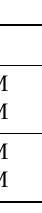
Table 1. The IC 50 values for DFIQ in H1299 and A549